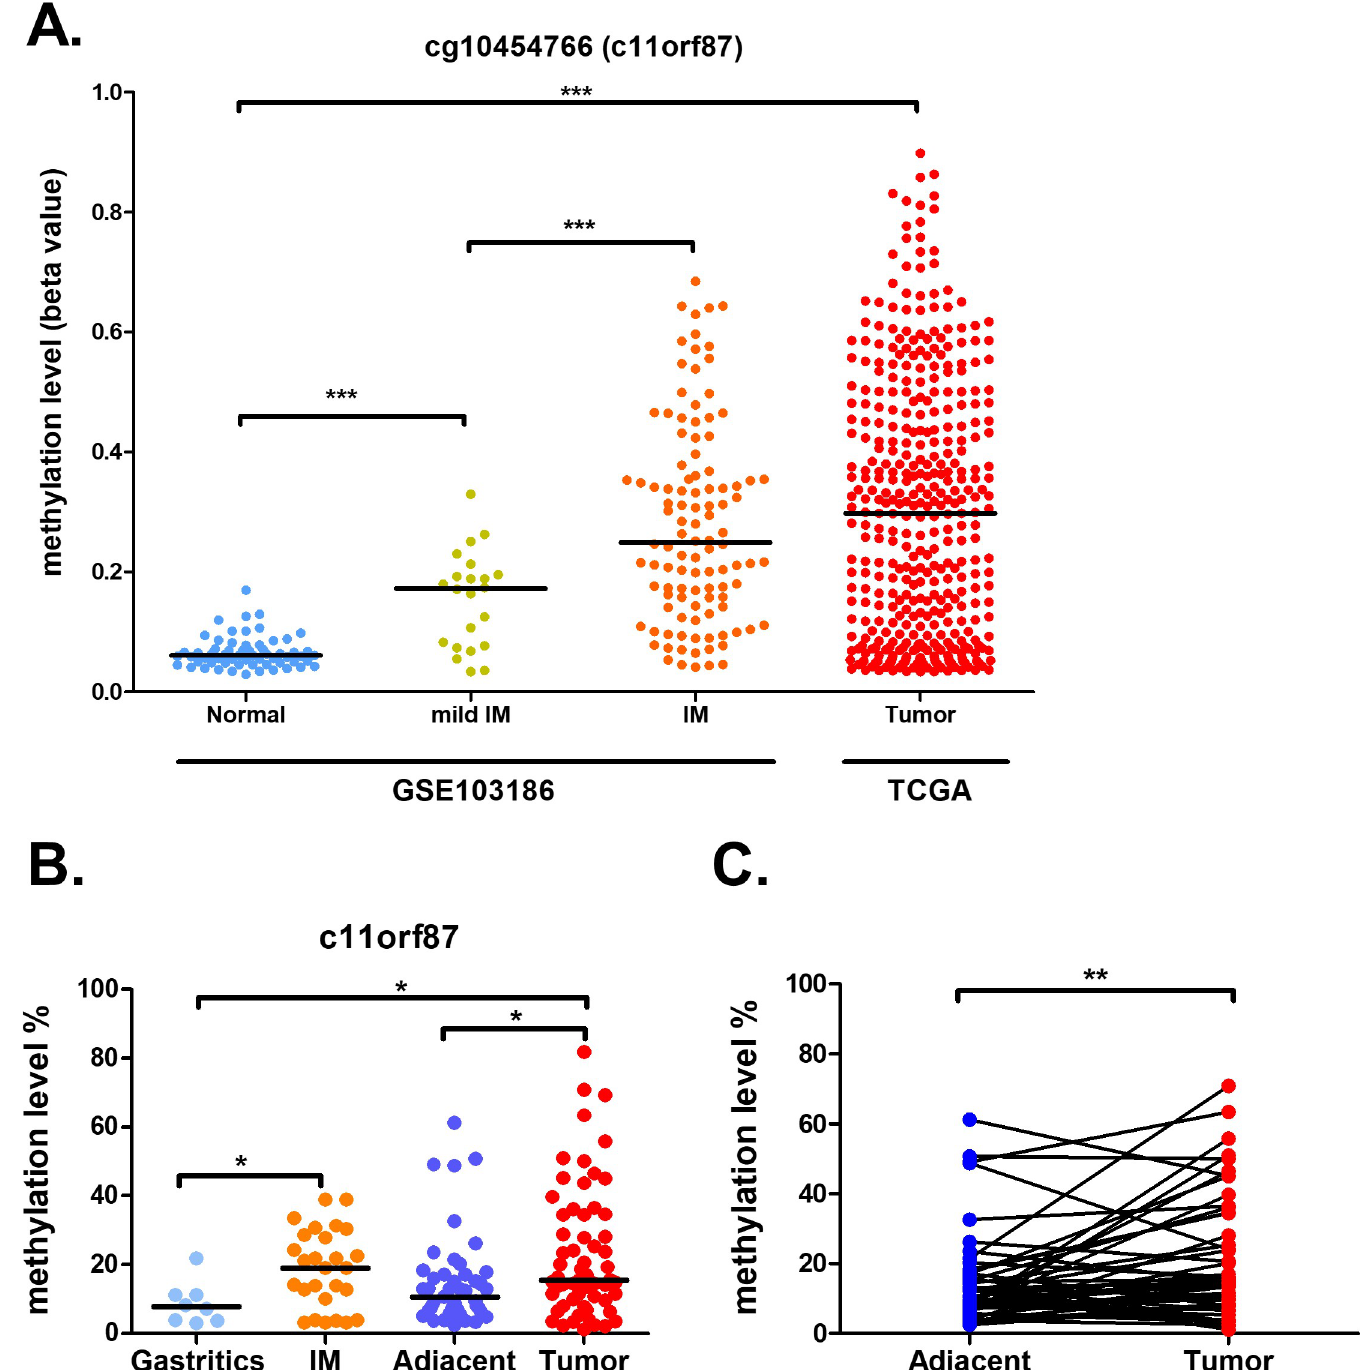
Fig 3. Progressive hypermethylation of cg10454766 in gastric carcinogenesis. (A) Methylation profile of cg10454766 from two datasets, GSE103186 and TCGA gastric cancer, including normal samples (n = 61), mild IM (n = 22), IM (n = 108) and cancer (n = 395). (B) Methylation of C11orf87 from our in-house samples including gastritis (n = 8), intestinal metaplasia (n = 27), tumor-adjacent normal (n = 47) to gastric tumor patients. (n = 62), as determined by bisulfite pyrosequencing. (C) Pairwise analysis of C11orf87 methylation in tumor-adjacent normal and tumor tissues (n = 47). Black lines denoted median values. Significant differences between groups and pairwise samples were indicated by � P < 0.05, �� P < 0.01, ��� P < 0.005, as determined by Mann-Whitney U-test or paired t-test, wherever appropriate.